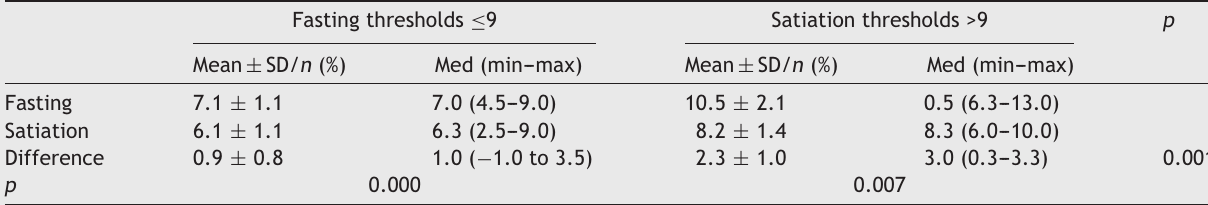
Table 3 Compare fasting threshold value of ≤ 9 and >9 with